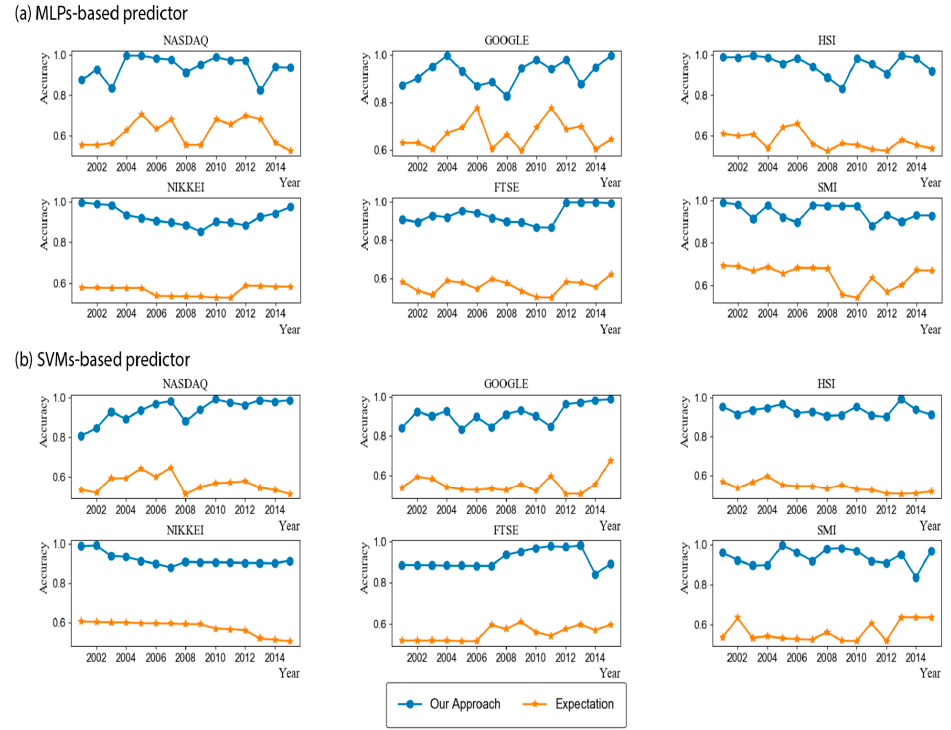
Figure 2. Accuracy comparison. ( a ) Accuracy comparison by Multilayer Perceptron (MLP)-based predictor; ( b ) Accuracy comparison by Support Vector Machine (SVM)-based predictor.